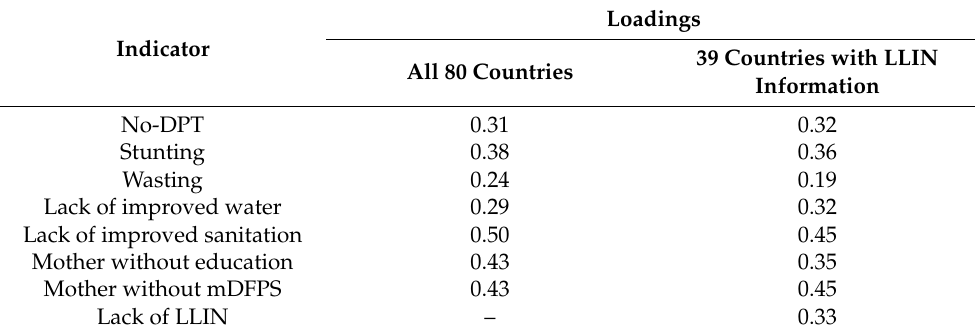
Table 2. Principal component analysis loadings for the eight deprivation indicators. Pooled analyses based on all children from the 80 countries (39 countries for bed nets).